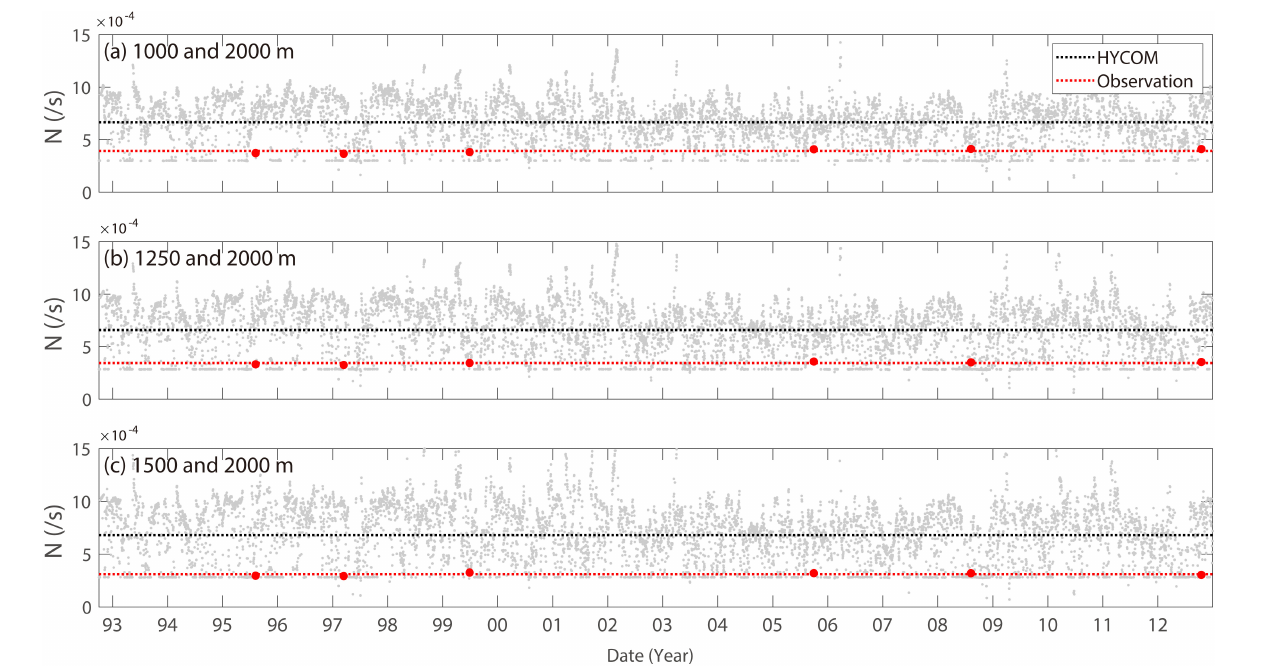
FIGURE 10 | Time series of buoyancy frequency between two depths using HYCOM data for Case 4 (gray dots). The CTD data taken near the grid in Case 4 are marked by red dots. The horizontal bars refer to the mean buoyancy frequency of the HYCOM data (black line) and CTD data (red line) at (a) 1000 and 2000 m, (b) 1250 and 2000 m, and (c) 1500 and 2000 m.